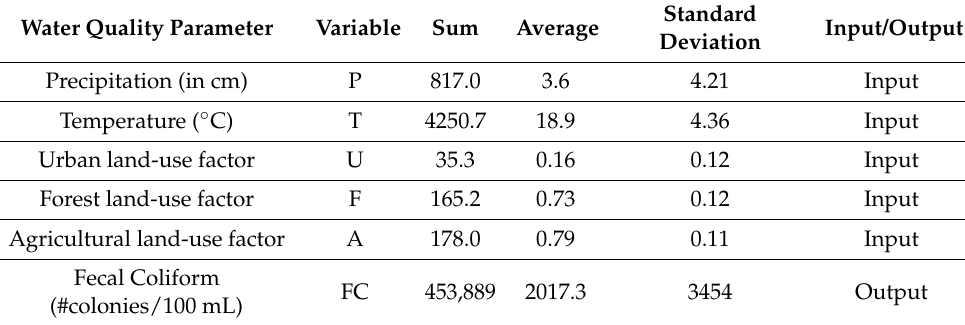
Table 1. Statistics of Water Quality Parameter and